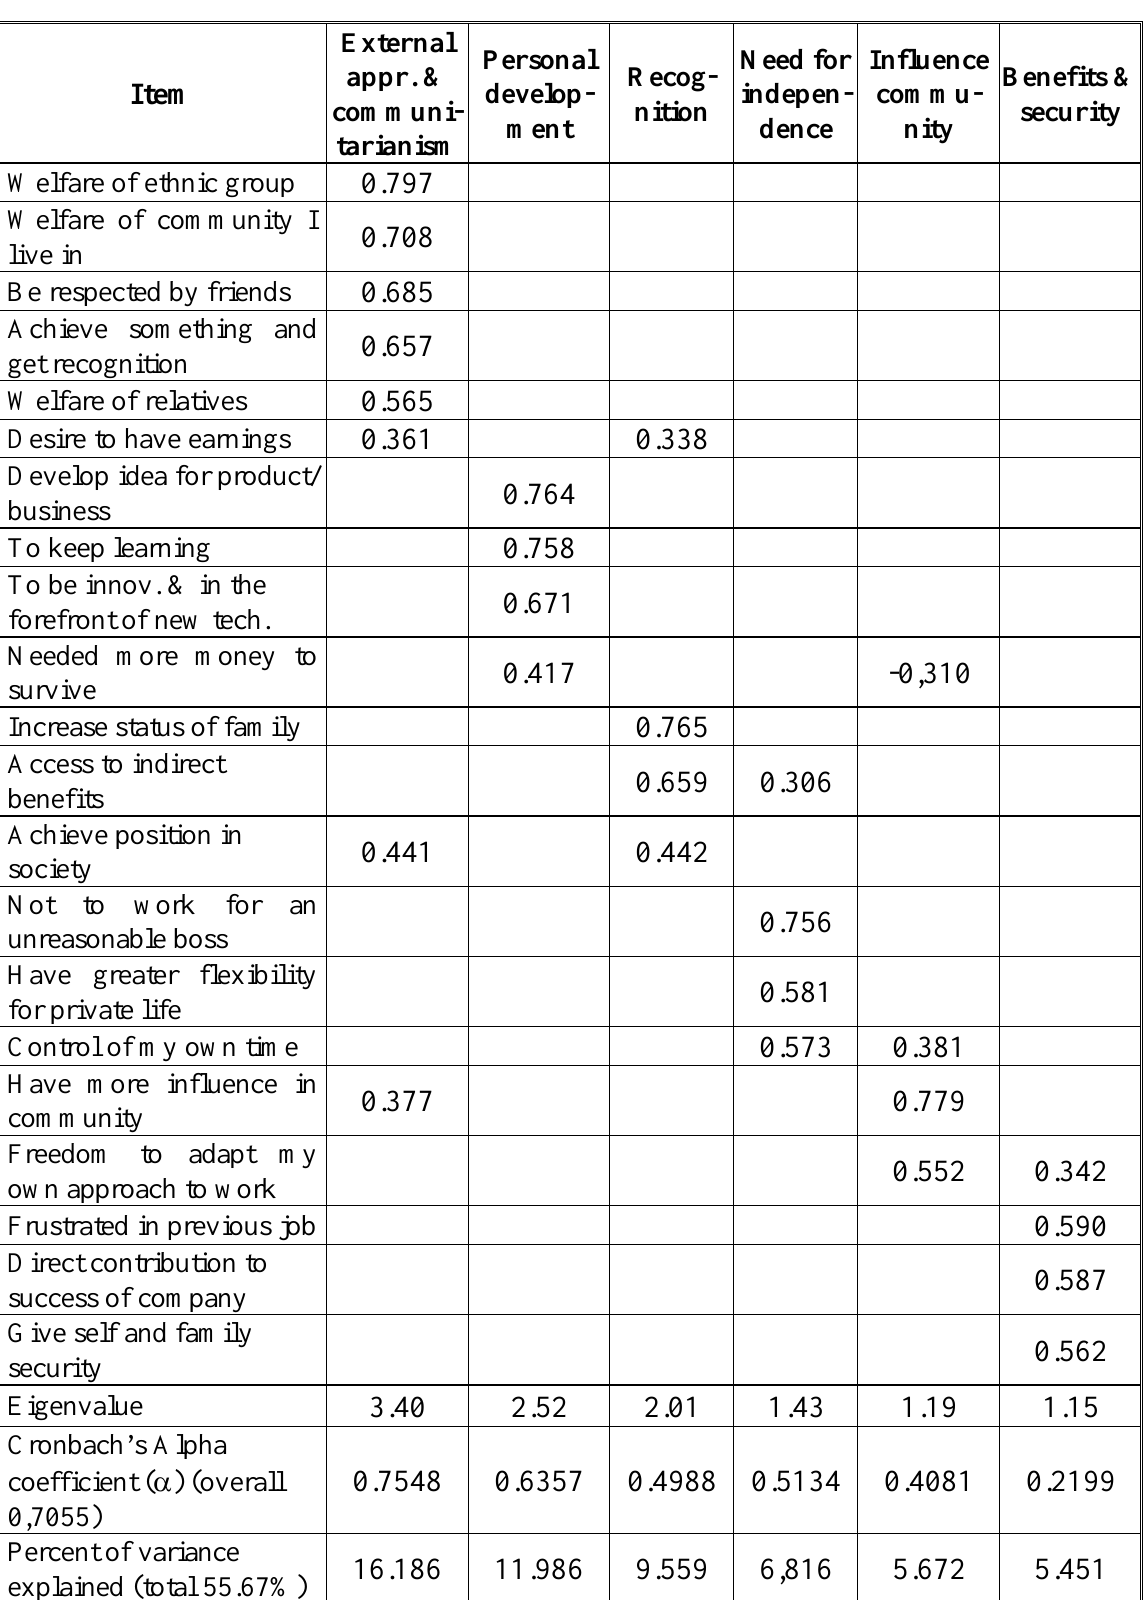
Rotated factor matrix for motivation